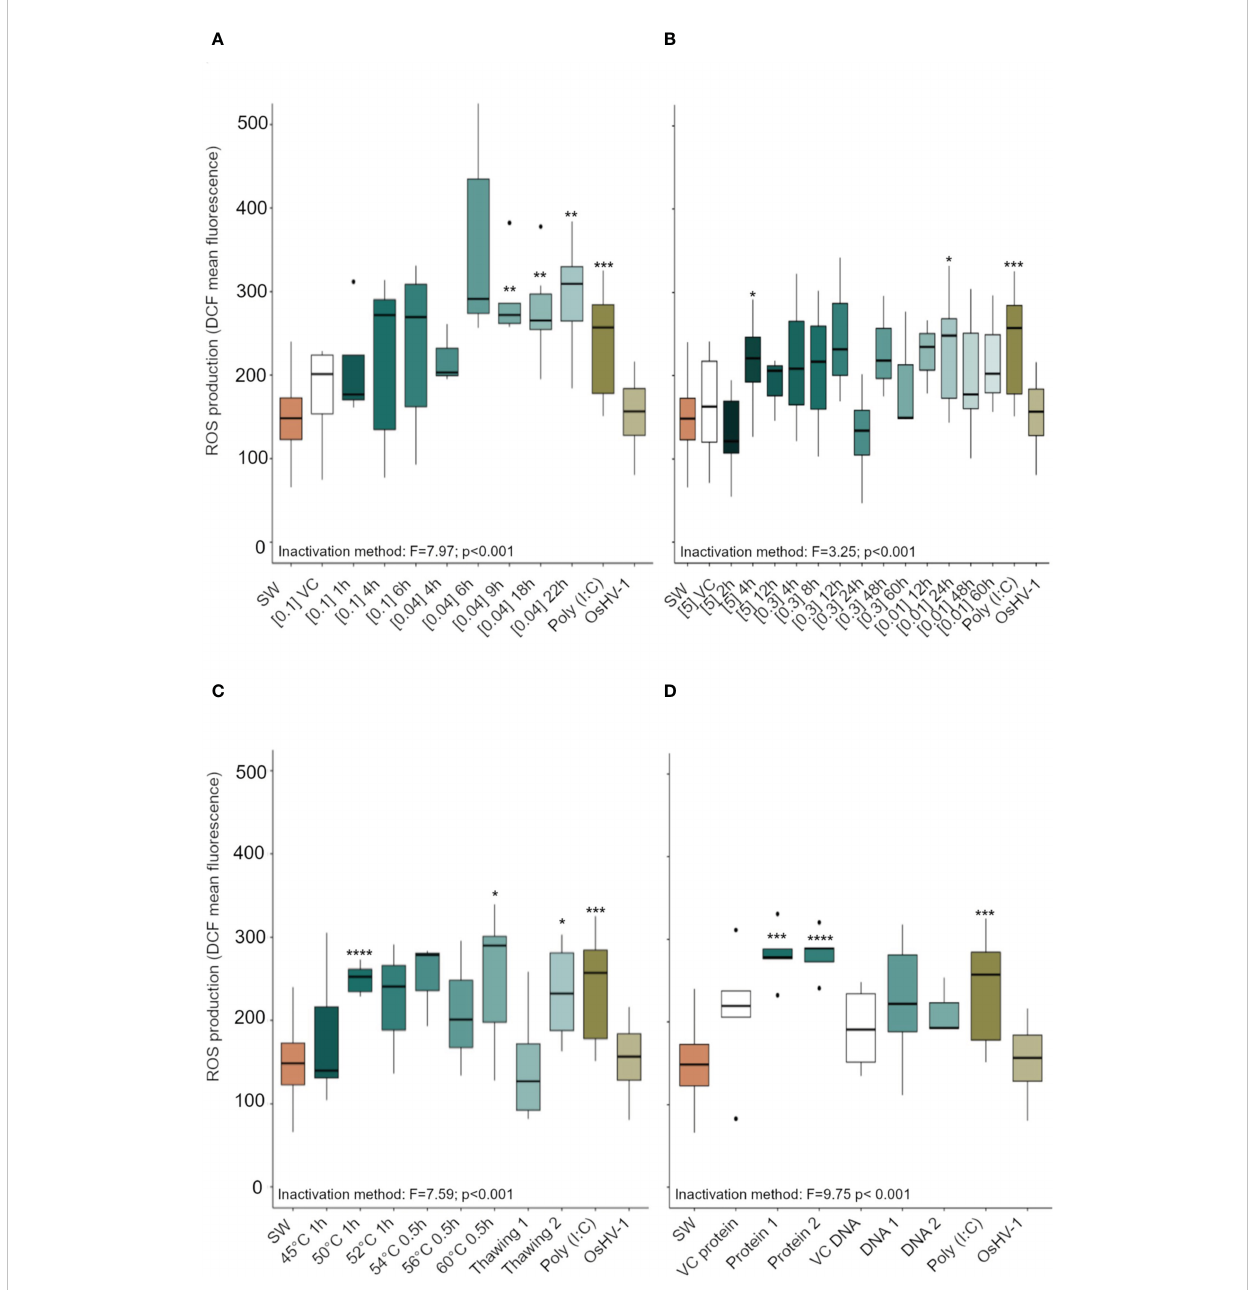
FIGURE 3 Reactive oxygen species (ROS) production (expressed in arbitrary unit, a.u) in Crassostrea gigas hemocytes exposed for 1 h to OsHV-1, which had been inactivated with different preparations of (A) Binary ethylenimine BEI, (B) formaldehyde, and (C) temperature treatments. (D) shows ROS production in hemocytes exposed to two viral protein concentrations and puri fi ed viral DNA (see Supplementary Table 1 for details of the different treatments). N = 3/6 replicates, box plots indicate the median, upper and lower quartiles; whiskers indicate the highest and the lowest values of the dataset and dots indicates outliers. Signi fi cance levels are expressed by asterisks: * (p < 0.05), ** (p<0.01), ***(p<0.001), **** (p<0.0001). ‘ SW ’ stands for seawater, ‘ VC ’ for vehicle